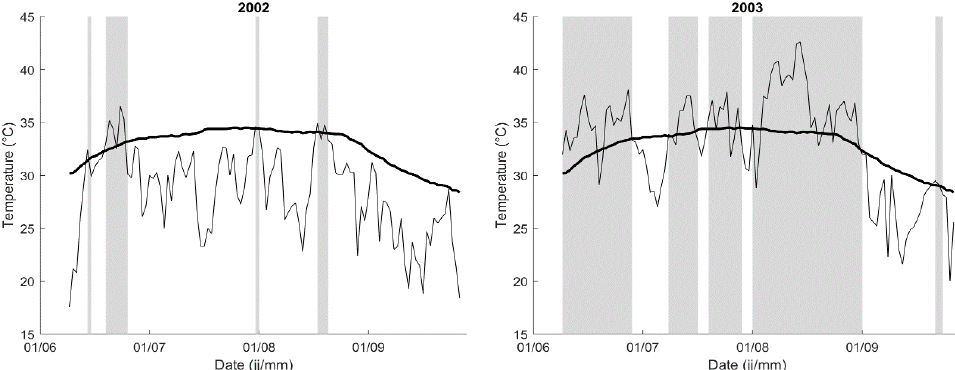
Figure 3. Daily maximum temperature (light line) and threshold of the 90th percentile of the maximum temperature (Bold line) for the years 2002 and 2003 in Orange. Extreme heat events are identified by the gray areas.